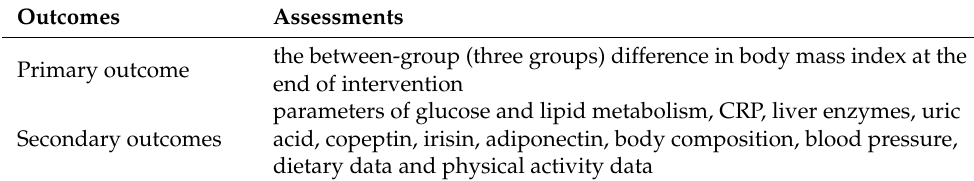
Table 2. Primary and secondary